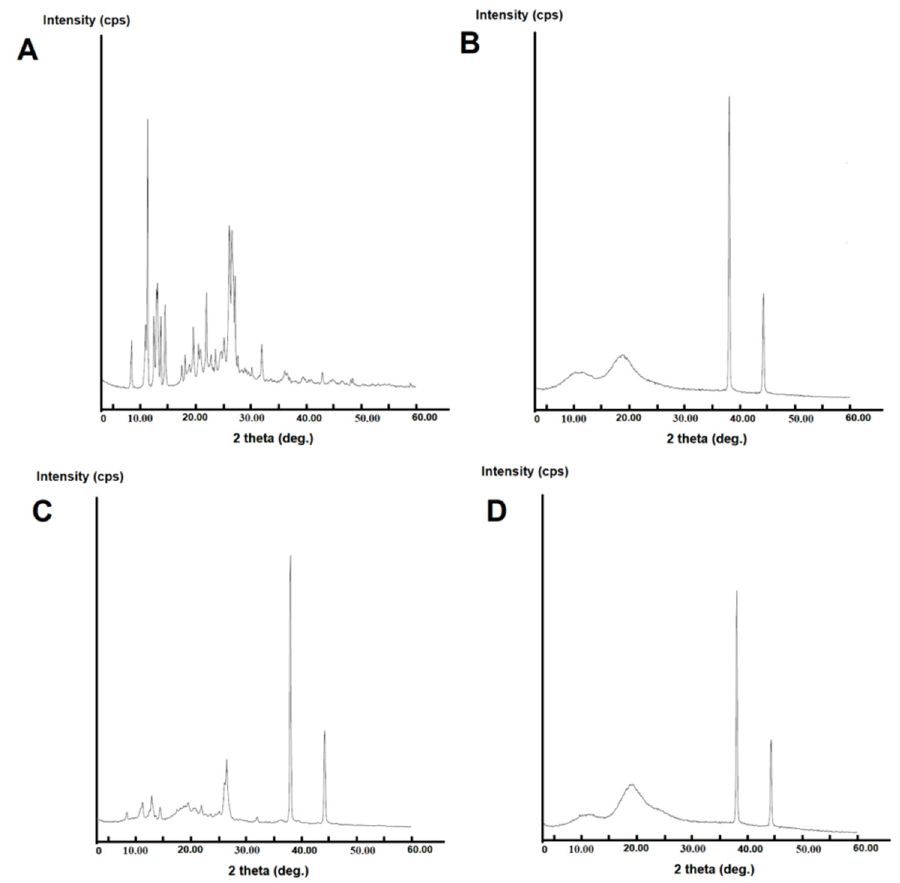
Figure 3. XRD patterns of ( A ) SA, ( B ) HPβCD, ( C ) BPM, and ( D ) BIC.